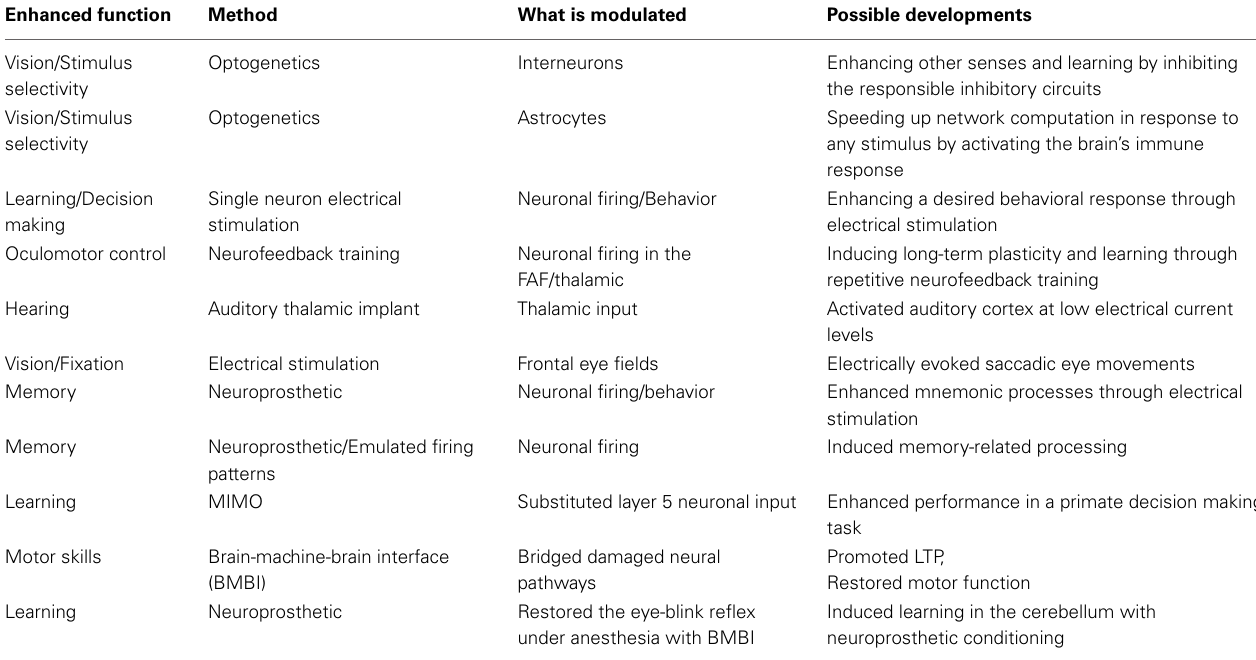
Table 1 | Summary of successful neurophysiological